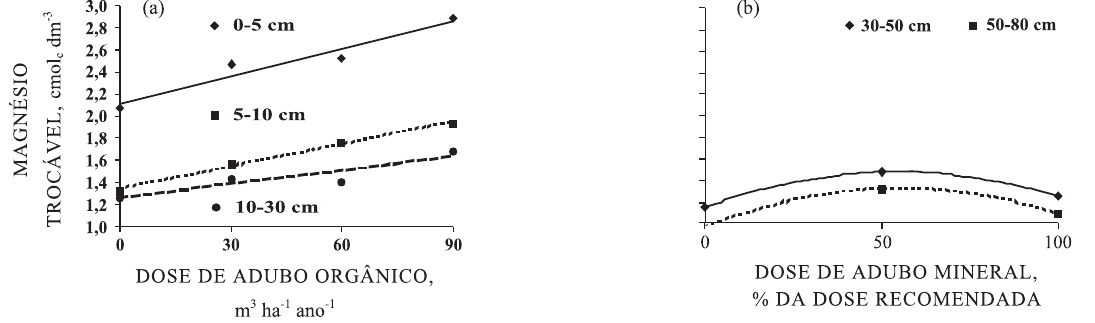
Figura 4. Teor de magnésio trocável em Latossolo Bruno sob plantio direto submetido a diferentes doses de esterco líquido de gado de leite e adubação mineral, por um período de seis anos, com remoção total da planta: (a) adubação orgânica; (b) adubação